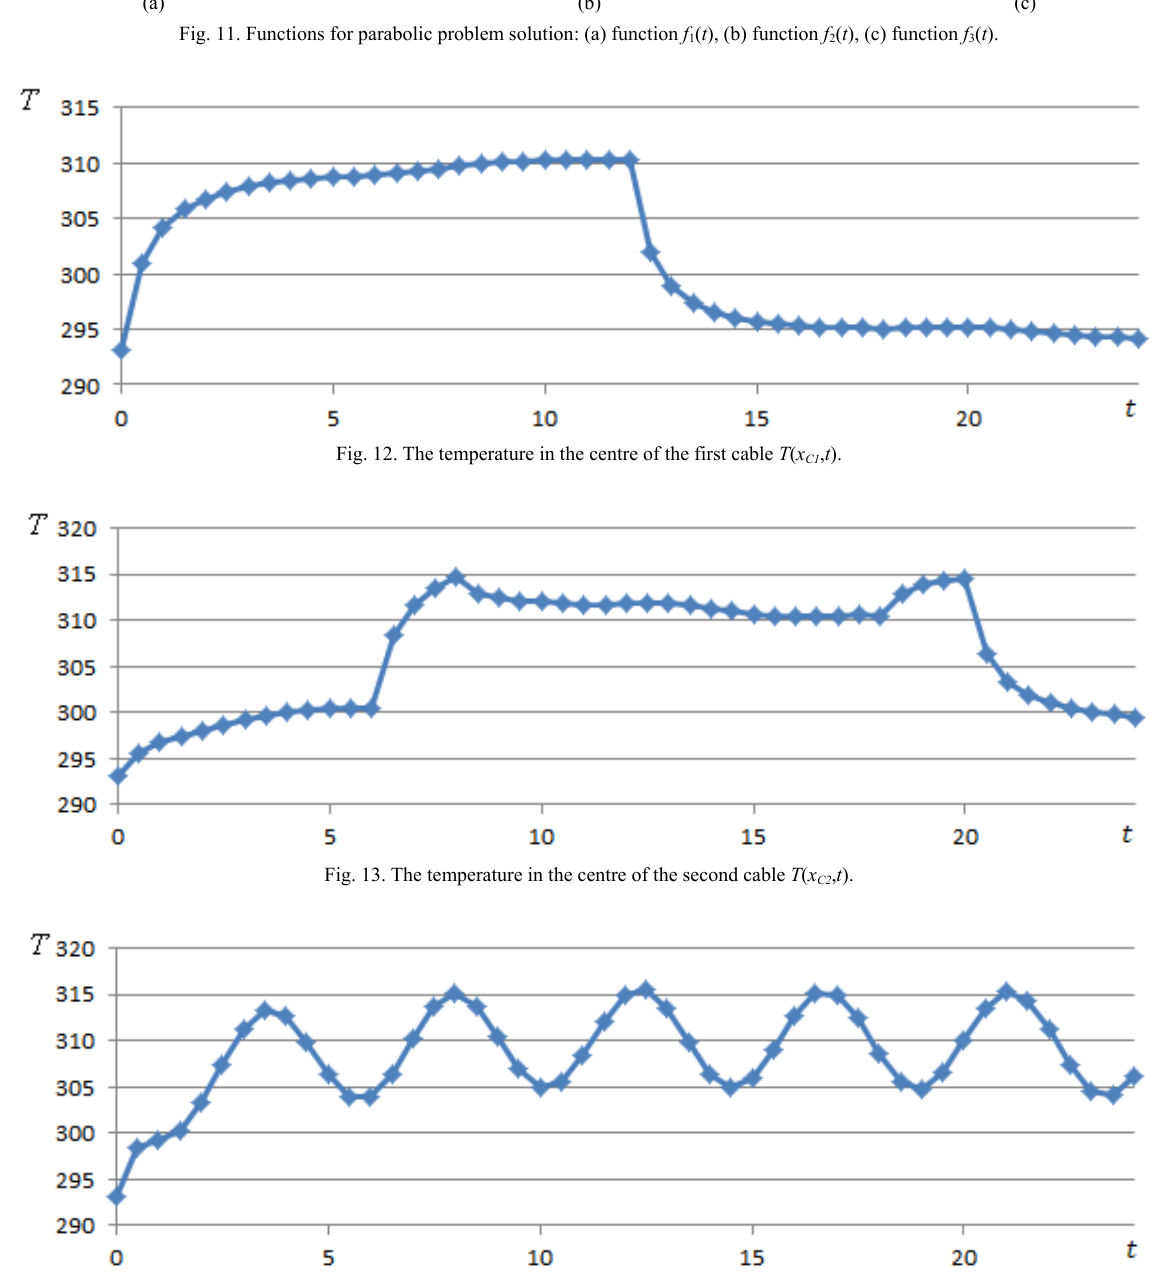
Fig. 14. The temperature in the centre of the third cable T ( x C3 , t